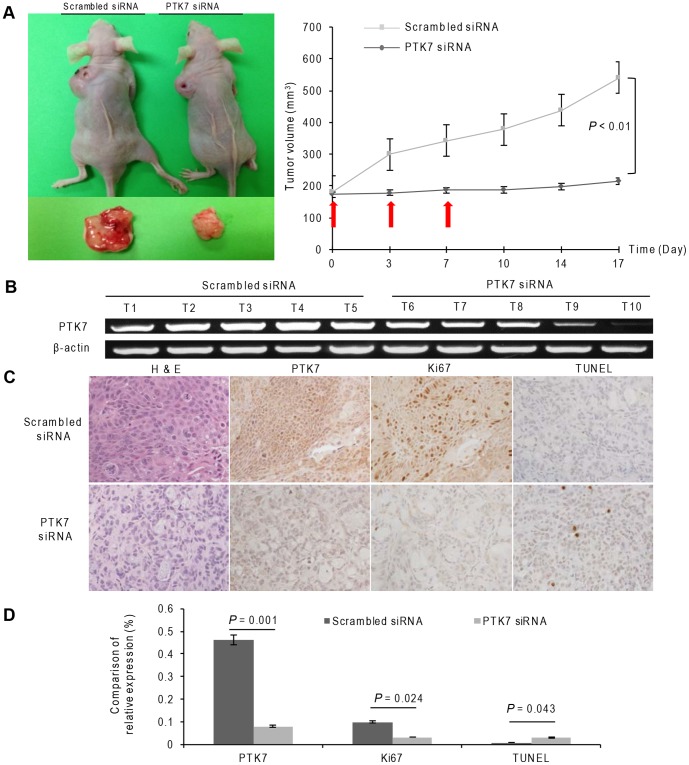
Effect of PTK7 silencing in a xenograft nude mouse model.(A) Representative nude mice in the PTK7-specific siRNA group and scrambled siRNA group (left panel). Tumor volume of the PTK7-specific siRNA-treated and the scrambled group (right panel). (B) PTK7 mRNA expression in each tumor. (C) Representative H&E, PTK7, Ki67, and TUNEL staining in the PTK7-specific siRNA and scrambled siRNA treated groups (original magnification, 200×). (D) Comparison of relative PTK7, Ki67, and TUNEL staining. P values are presented for comparison with the scrambled siRNA group. Data represent the mean ± SD.